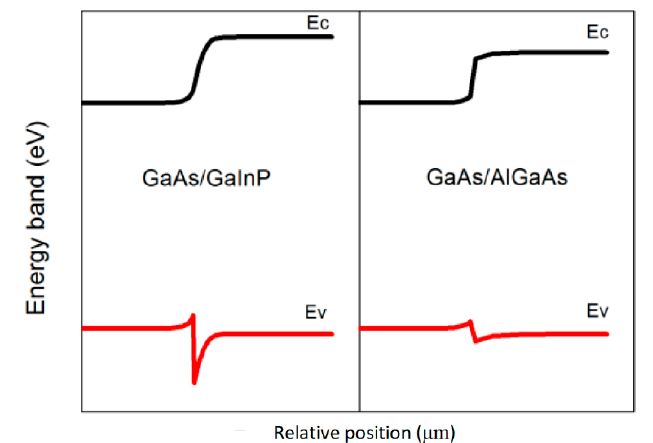
Figure 5. Band diagram of a p-GaAs / pAl 0.2 Ga 0.8 As heterojunction. (Right) band diagram of a p-GaAs / pGa 0.5 In 0.5 P heterojunction. In both cases the doping level is constant throughout the heterojunction and equals N A = 2 × 10 18 cm − 3.